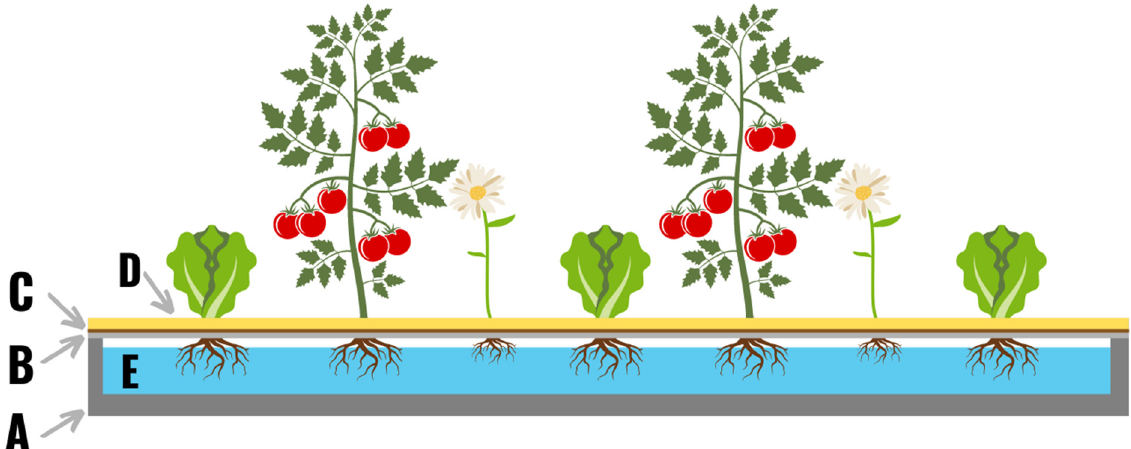
Figure 1. The original hydroponic system built by Gericke in 1929. A roll of bituminous roofing paper (36 ft × 3 ft) was folded up on every edge 6 inches to form a trough ( A ). On top of the trough a layer of wire netting was attached ( B ), and a layer of burlap ( C ) was added on top of the wire. A one-inch layer of sand ( D ) was added on top as a substrate for the plants to grow in. The trough was filled with nutrient solution ( E ), and a variety of crops were planted in the system.